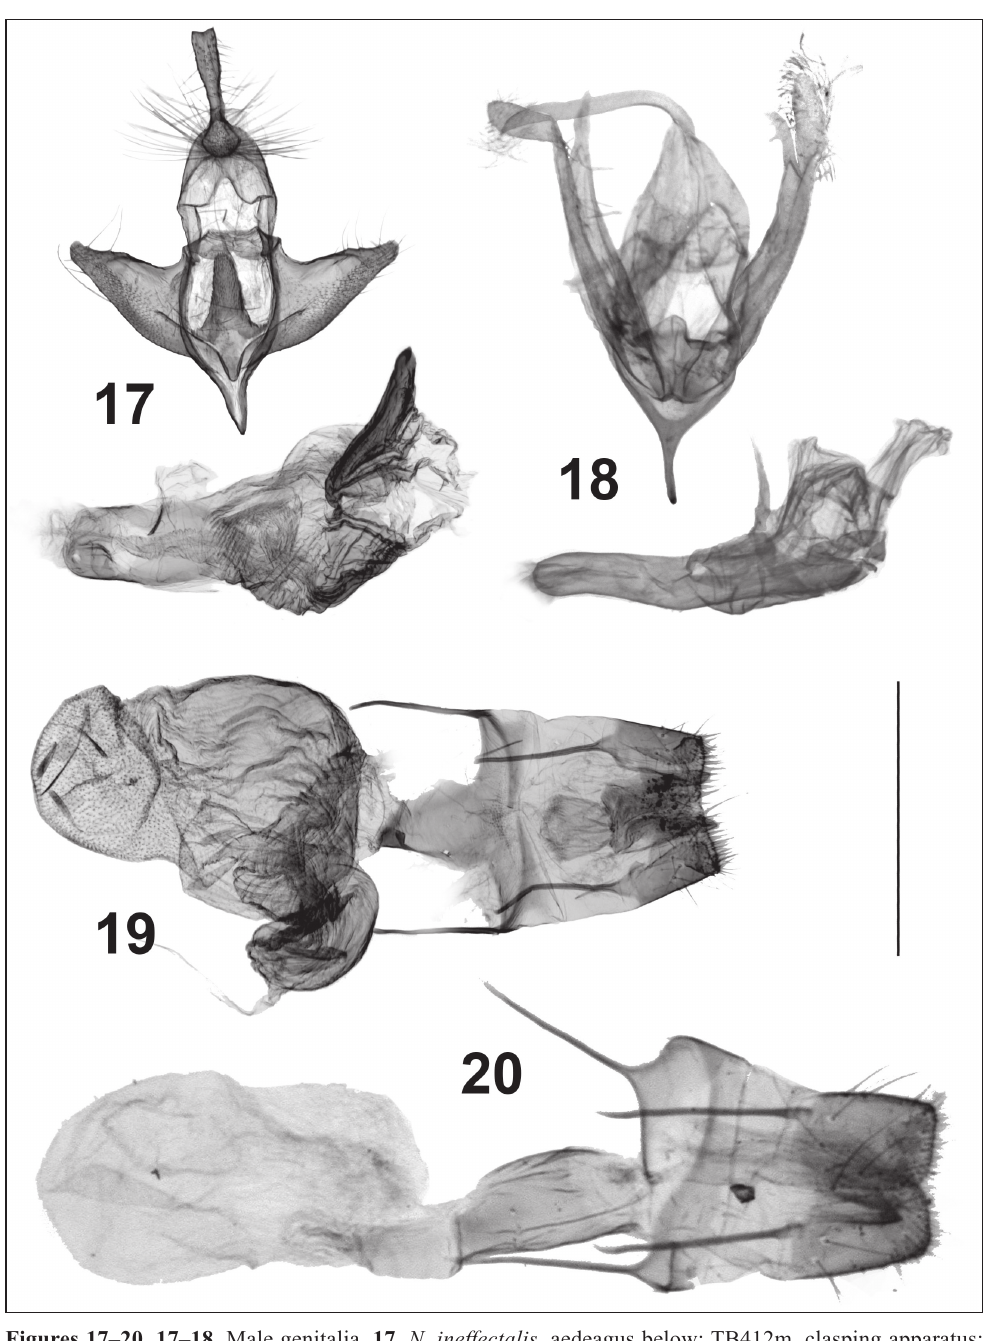
19–20. Female genitalia. 19. N. ineffectalis ; slide No. TB414f (coll. HNHM). 20. N. notata , syntype; slide No. BM 21613♀ (coll. NHMUK). Scale bar: 1 mm. Figures are to